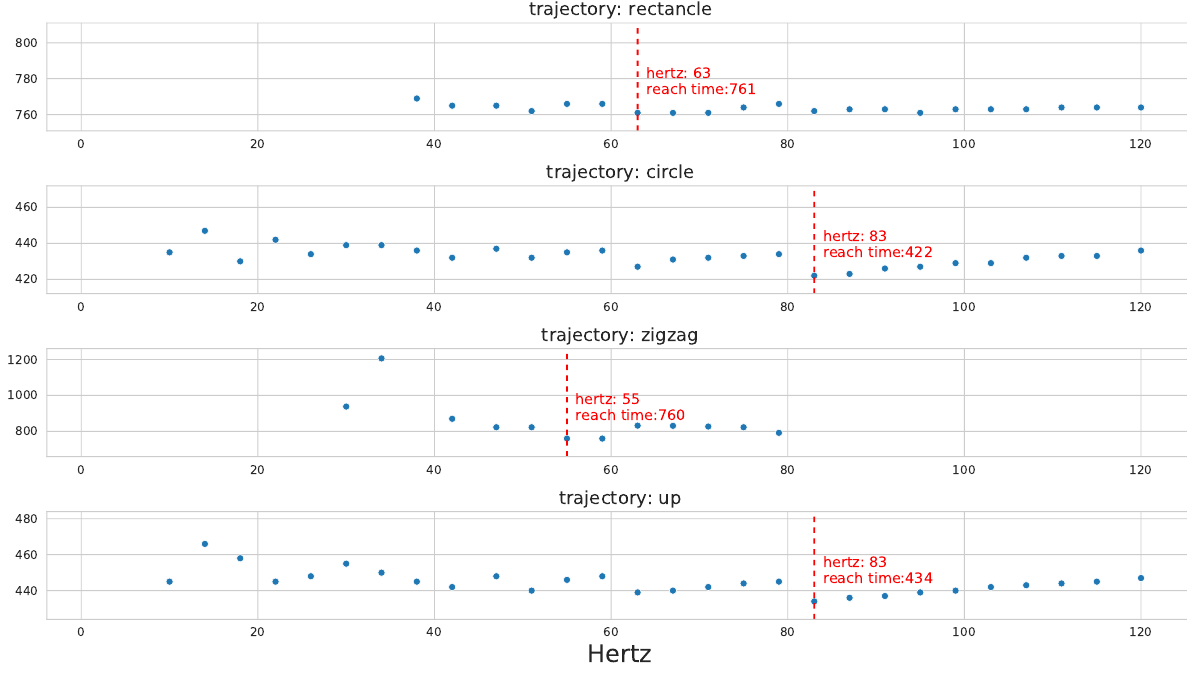
Figure 7. The results of best position frequencies for the four trajectories. X-axis represents a frequency (in hertz) for the position control, and Y-axis represents the reach time of the last waypoint. The dashed red line indicates the optimal position frequency that minimizes the reach